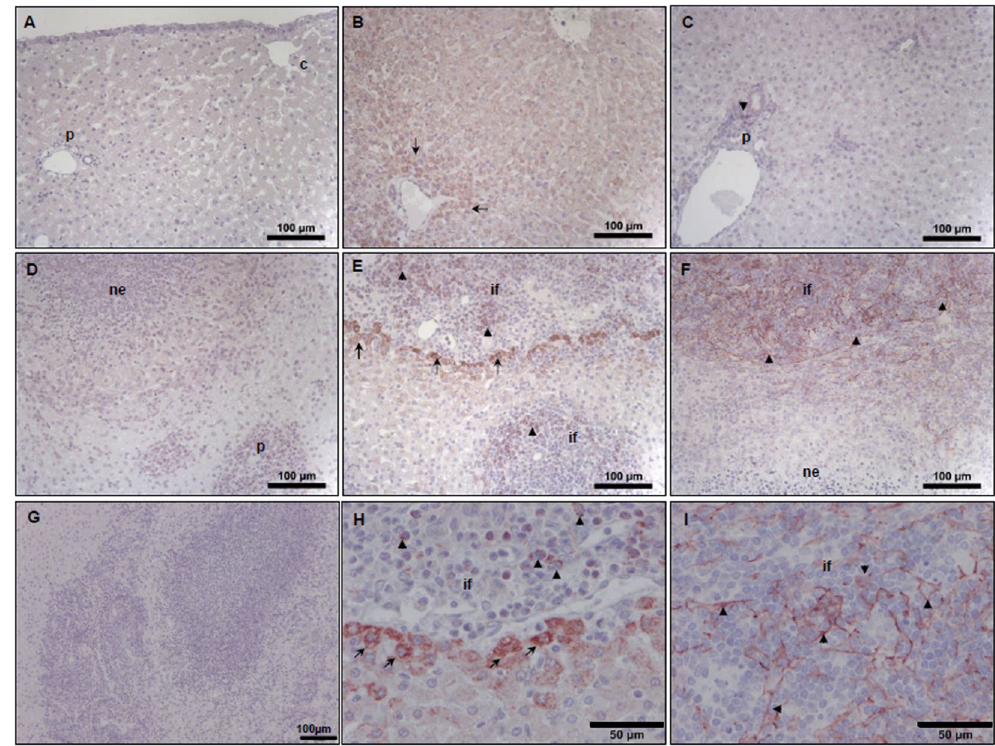
Figure 6. Immuno-labelling potential biomarkers of liver damage. Liver sections from uninfected ( A , B , C ) and infected sheep ( D , E , F , H , I ) were probed with periostin rabbit anti-mouse polyclonal antibody ( B , E and H ) and Vascular cell adhesion protein 1 (VCAM-1) rabbit anti-rat, mouse, human monoclonal antibody ( C , F and I ). Rabbit pre-immune serum ( A and D ) and staining using the goat anti-rabbit biotinylated secondary antibody only ( G ) were used as negative controls. Panels H and I are high powered images of panels E and F representing periostin and VCAM-1 staining, respectively. Periostin reactivity in the uninfected sheep ( B ) is found in the cytoplasm of hepatocytes, particularly in perilobular areas (arrows), whereas in the infected sheep ( E and H ) strong reactivity is found in hepatocytes (arrows) adjacent to inflammatory infiltrates (if) surrounding necrotic foci and in inflammatory cells (arrow heads). VCAM-1 is weakly expressed in the uninfected sheep ( C ) but strongly expressed in acute infection ( F and I ) particularly in the inflammatory infiltrates (if) showing a reticular pattern (arrow heads). ne: acute necrotic foci; if: inflammatory infiltrate; p: portal space. Scale bars represent 100 µ m ( A – G ) and 50 µ m ( H and I